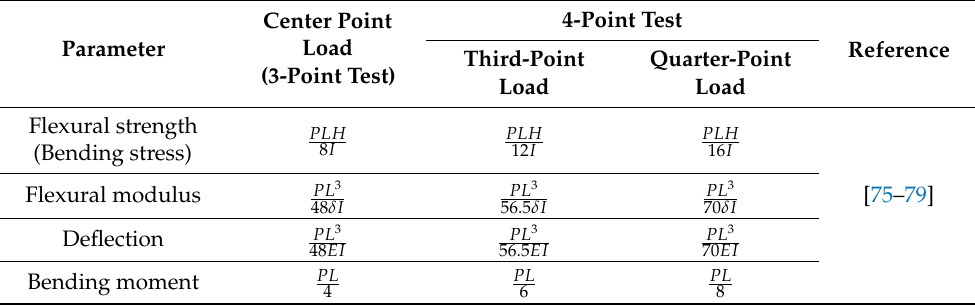
Table 5. Mechanical parameters quantifiable from a flexural test (3-point and 4-point testing). Center Point Parameter